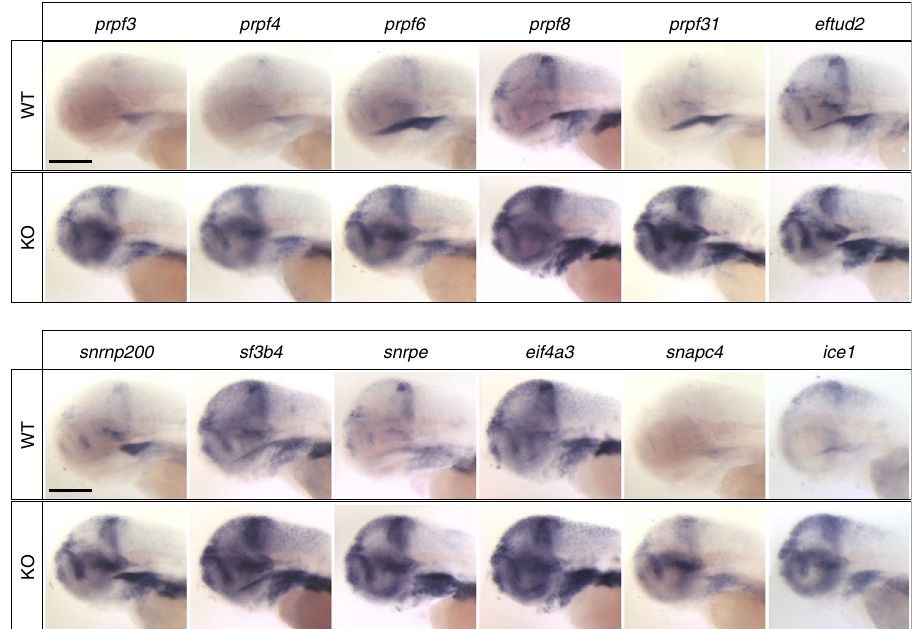
Fig. 5 Major spliceosome effectors are upregulated in fam50a KO zebra fi sh. Representative lateral images of whole-mount in situ hybridization performed on 3 day post-fertilization larvae validate RNA-seq data (Table 2) from fam50a KO (homozygous mutant) vs wild-type (WT). Number of embryos assessed with similar results: prpf3 , n = 11; prpf4 , n = 10; prpf6 , n = 11; prpf8 , n = 10; prpf31 , n = 11; eftud2 , n = 10; snrnp200 , n = 11; sf3b4 , n = 11; snrpe , n = 11; eif4a3 , n = 9; snapc4 , n = 11; ice1 , n = 10. Scale bars; 200 μ